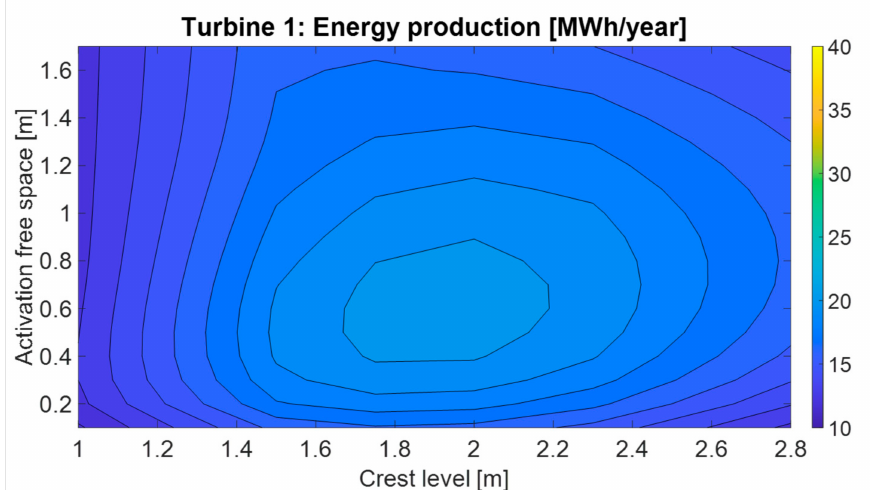
Figure 7. Energy produced by Turbine 1 as a function of the activation free space f a and the crest level h cr